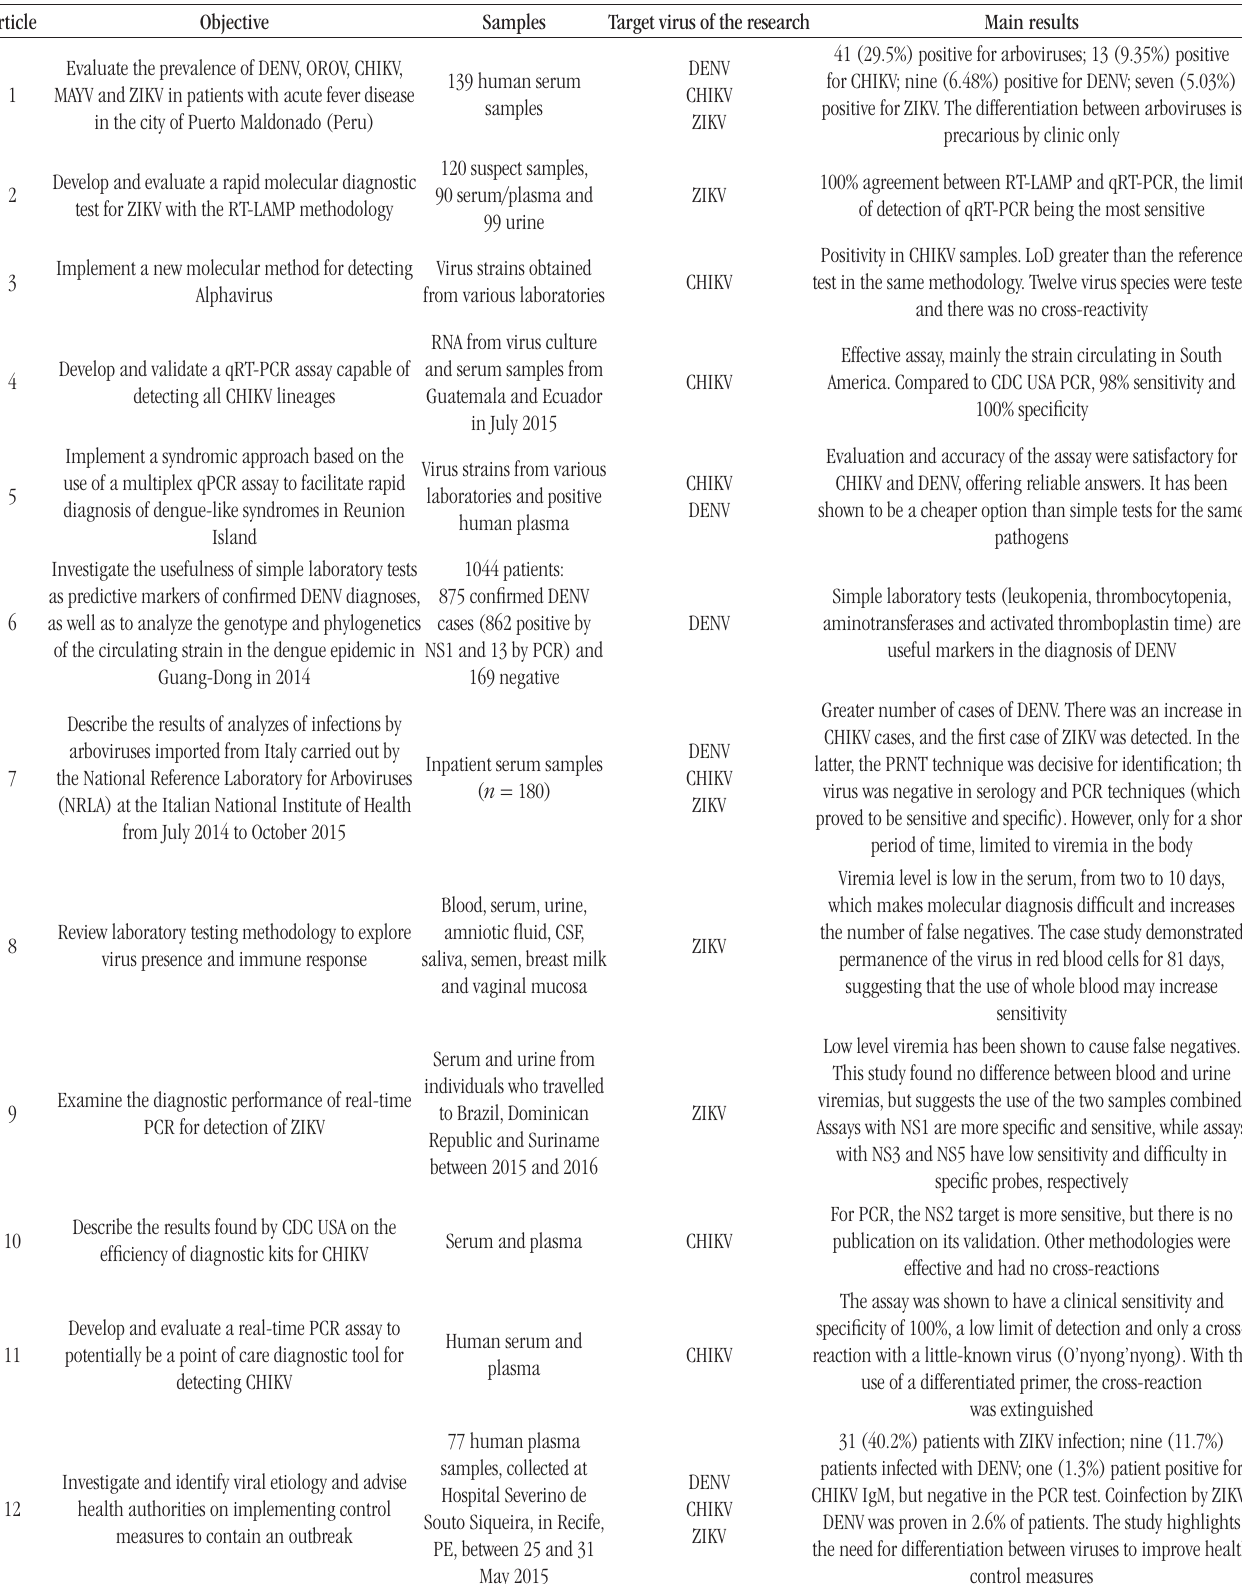
TABLE 2 – Objectives of selected articles, samples used in the studies and brief summary of the main